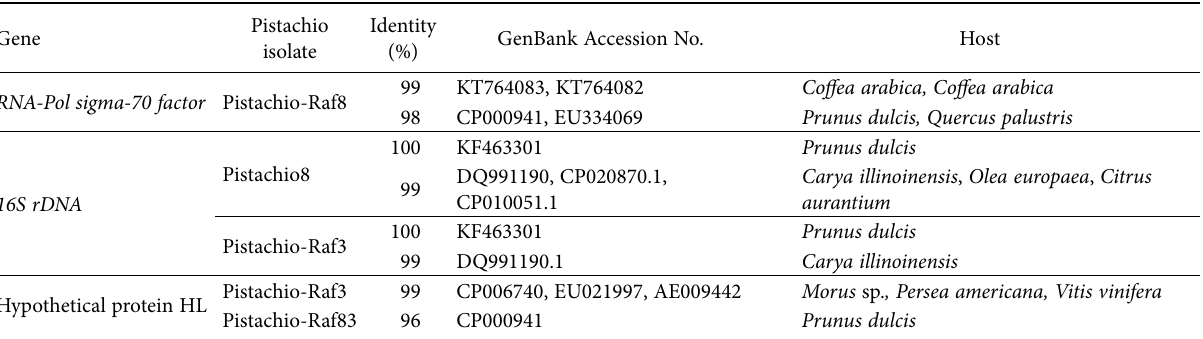
Table 2. Maximum nucleotide identity (%) of selected gene sequences between Xylella fastidiosa strains from pistachio and X. fastidiosa strains from other hosts present in Genbank. Respective accession numbers for isolates from pistachio are the following: RNA-Pol sigma-70 factor (MG601055), 16S rDNA (MG517438.1, MG458715) and Hypothetical protein (MG732899, MG732900, MG732901). Accession num- bers relative to strains are reported in